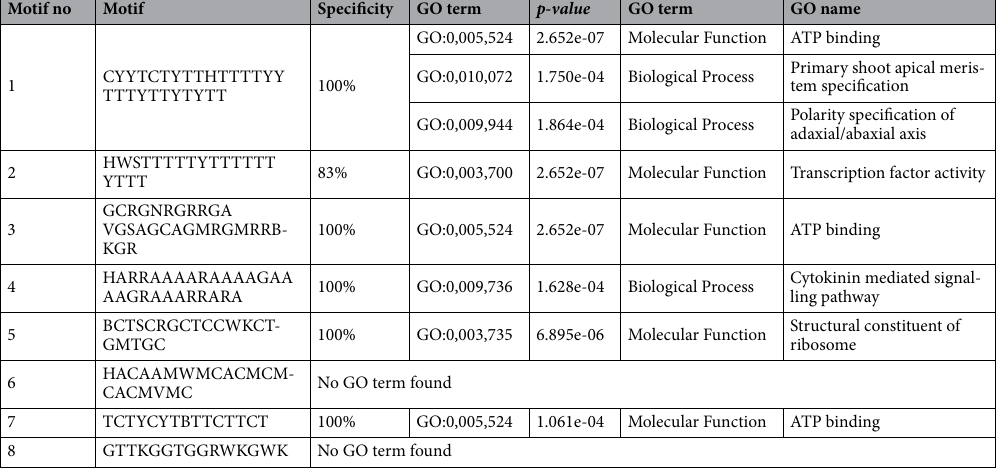
depicted by green and pink lines respectively. The other node colours represented various interactions which included teal (from curated databases), blue (gene co-occurrence), dark green (co-expression) and lilac (protein homology). The clustering divided the proteins into five clusters with average local clustering coefficient of 0.41. The proteins in the same cluster shared similar biological function, such as red (response to gibberellin), yel- low (WD repeat-containing domain superfamily), green (cytokinin metabolism), cyan (phosphoproteins) and blue (proteins without any significant clustering co-efficient). The results indicated that the proteins encoded by genes CsDEFICIENS and CsDELLA occupied the central positions in two different clusters. The CsDEFICIENS interacted with CsPISTILLATA, CsSEP1 and CsFIE . Both PISTILLATA and SEP1 (SEPALLATA) are MADS box transcription factor proteins 48,49 . The protein encoded by CsDELLA was related to proteins having functions as gibberellin oxidase (encoded by CsGA20OX, CsGA2OX, CsGA20OX2 ), cytokinin oxidase (encoded by CsCKX2, CsCYP735A2 ), Gibberellin Insensitive Dwarf receptor (encoded by CsGID ) and lonel guy enzyme (encoded by CsLOG ). The CsAux/IAA and CsARF8 were connected with CsIAA9 and CsGH3 respectively. Evaluation of SSR markers. Simple sequence repeats (SSRs) were mined in the genomic, coding and cDNA sequences of PRGs. One hundred and four SSRs were identified, which are presented in Table S7. The distribution of the 104 SSRs across genomic, cDNA and coding sequences are shown in Fig. 8a. Most SSRs are harboured in genomic sequences which included mono-, di-, tri-, tetra- and penta-nucleotide repeats and in compound formation (Fig. 8b). The most abundant form of SSRs was as mononucleotide repeats followed by dinucleotide repeats and compound SSRs. The distribution of SSRs across individual PRG in case of genomic, cDNA and coding sequences is shown in Fig. 8c. The maximum number of SSRs were detected in PISTILLATA followed by WD40 and ARF8 . The SSR markers were validated via PCR amplification and product separation via PAGE (Polyacrylamide gel electrophoresis). A total of 31 pairs of primers were designed based on these markers (Table S8). Out of the total, three primers for the genes CsPIN-4 and CsWD40 showed polymorphism within the parental genotypes i.e. Punjab Kheera-1, Gy-14, PBRK5, Punjab Naveen and AVCU1303 (Fig. 9). Expression analysis of PRGs in five cucumber lines. We examined the expression of nine PRGs ( CsPIN-4, CsIAA, CsMEDEA, CsDEFICIENS, CsCKX2, CsWD40, CsDELLA, CsPISTILLATA, and CsCYP78A6 ) in five genotypes of cucumber including Gy-14 (gynoecious and non-parthenocarpic), AVCU1303 (sub-gynoe- cious and non-parthenocarpic), Punjab Naveen (monoecious and non-parthenocarpic), PBRK5 (monoecious and weak parthenocarpic) and Punjab Kheera-1 (gynoecious and parthenocarpic) using qRT-PCR (Fig. 10). Leaf samples were collected from each variety at 7, 14 and 21 days after flowering (DF). The nine PRGs cho- sen for validation were selected based on their function. All the genes selected were components of different pathways (phytohormone metabolism and signalling, reproductive development and regulation of biological processes) and had fallen under different GO terms (Table S2). The leaf samples were chosen for the study as a study conducted by Wang et al. 40 revealed that the tissue specific expression of GA20ox2 was the maximum in leaf sample of pear. CsPIN-4 and CsDEFECIENS were down-regulated in parthenocarpic cucumber ‘Punjab Kheera-1’ with high fold changes (~ 2) (Fig. 10a and d). The genes CsIAA, CsCKX2 , CsWD40 , CsDELLA , CsPIS- TILLATA and CsCYP78A6 were down-regulated in both parthenocarpic and non-parthenocarpic genotypes; however, the decrease in expression level was less in parthenocarpic as compared to non-parthenocarpic ones. The gene CsMEDEA was positively regulated in all genotypes except Gy14 (non-parthenocarpic) and Punjab Kheera-1(parthenocarpic) with slightly negative gene expression. The fold change was the highest at 21 DF for all the genes except CsPISTILLATA in case of non-parthenocarpic genotype. The expression level was high at 7 DF, which decreased at 14 DF and again increased up to 21 DF. The inconsistency in the patterns followed by the expression level of the PRGs was consistent with the results of Li